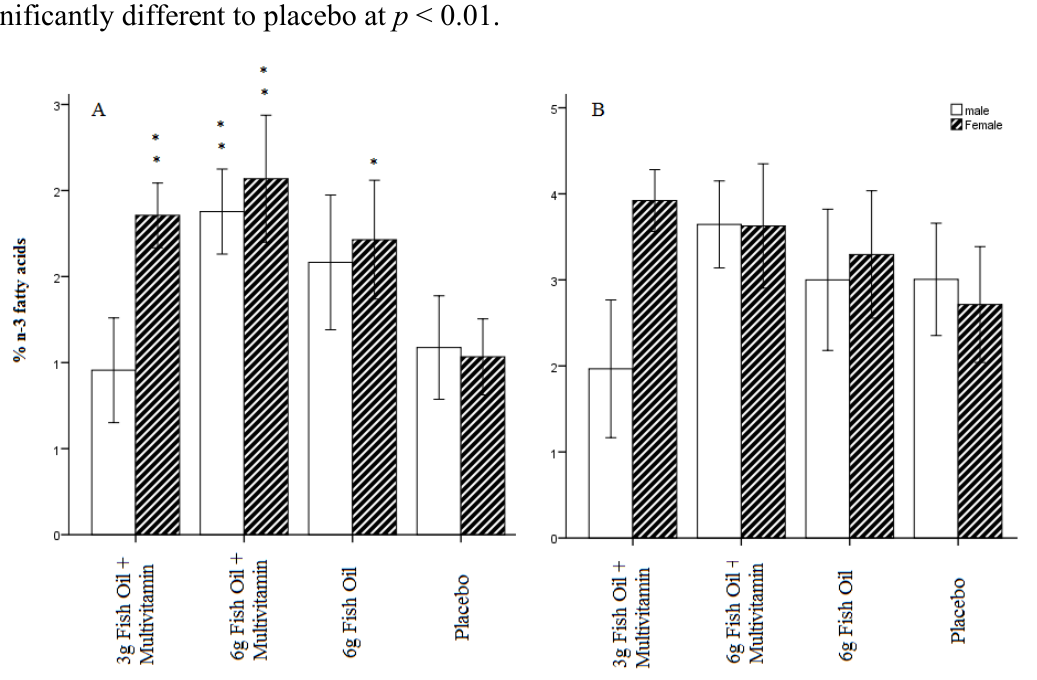
Figure 3. Incorporation of EPA ( A ) and DHA ( B ) into red blood cells at study endpoint stratified by treatment allocation and gender. Males are represented by white bars and females by shaded bars. * Group significantly different to placebo at p < 0.05, ** Group significantly different to placebo at p <